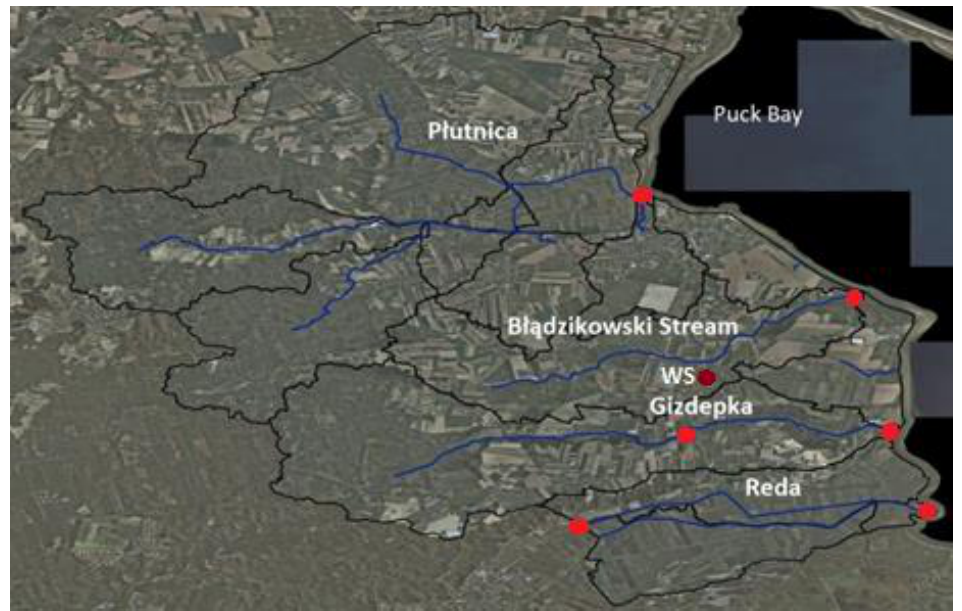
Figure 2. Main rivers and their sub-basins (source: geoportal.gov.pl), red point—field measurement, WS—weather station.